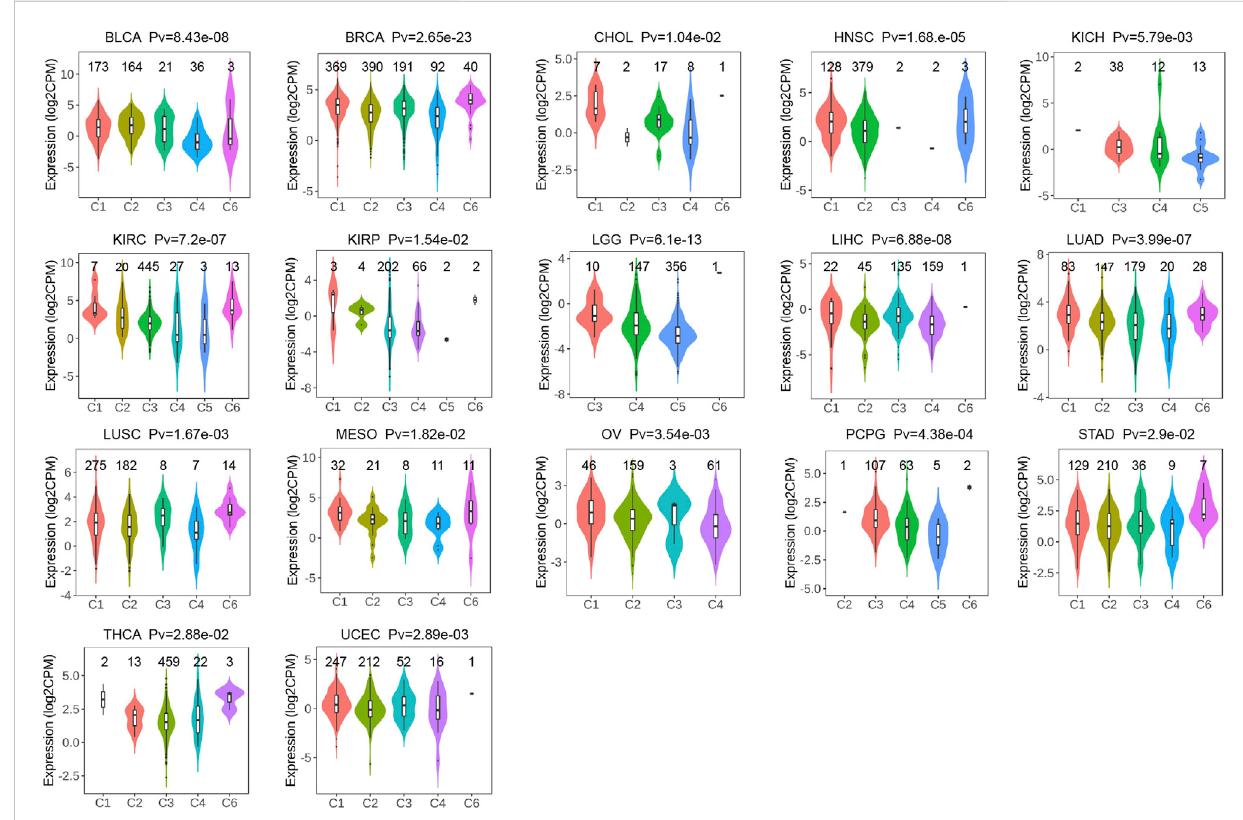
FIGURE 5 The relationship of P4HA3 expression with immune subtypes in BLCA, BRCA, CHOL, HNSC, KICH, KIRC, KIRP, LGG, LIHC, LUAD, LUSC, MESO, OV, PCPG, STAD, THCA, and UCEC. The different colors represent the different immune subtypes.